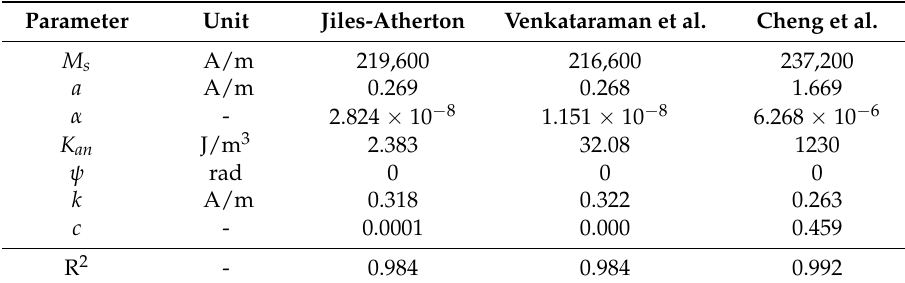
Table 1. Parameter identification results for the three models.